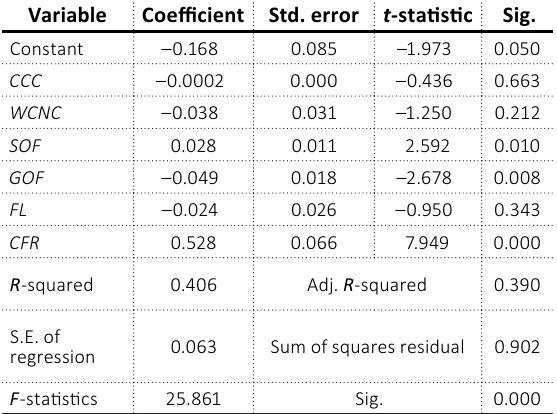
Table 6. Determinants of cash holding (CH) (large firms)